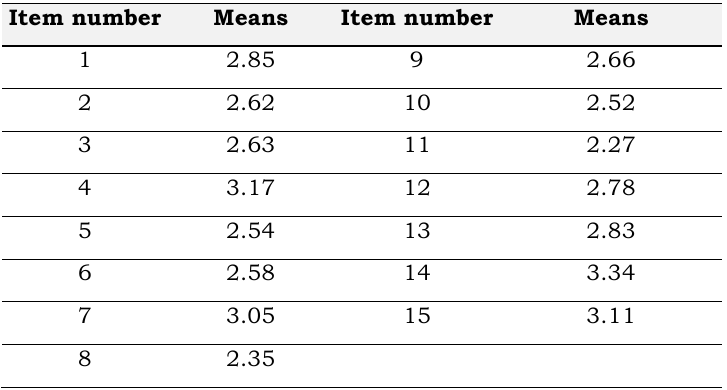
Table 1: The means of responses on SPCC questionnaire Item number Means Item